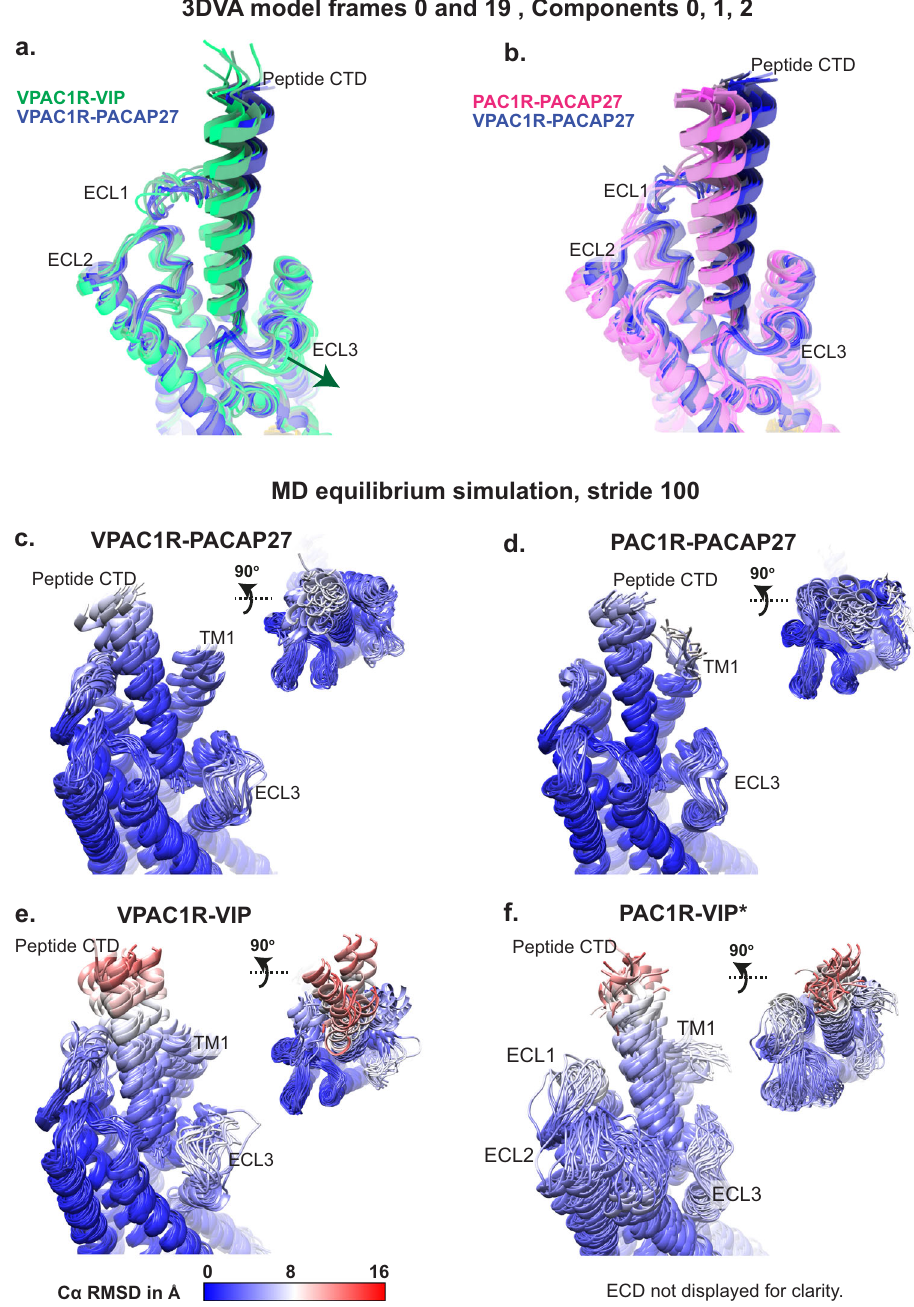
Fig. 3 | Dynamic analyses of receptor-peptide complexes by cryo-EM 3D variability analysis and MD simulations. a , b VPAC1R-VIP (green), VPAC1R- PACAP27(blue)andPAC1R-PACAP27(pink)atomiccoordinateframesderivedfrom the cryoSPARC 3DVA extreme frames (frame 0 and 19) from each component (component0 to 2) were overlayed and different frames werecoloured ina colour gradient according to their peptide-receptor pair (Comp 0, frame 0 lowest saturation, Comp 2, frame 19 highest saturation). c – f Snapshots of the MD equili- brium simulation from the experimental structures of VPAC1R-PACAP27, PAC1R- PACAP27 and VPAC1R-VIP, as well as the PAC1R-VIP homology model (as indicated